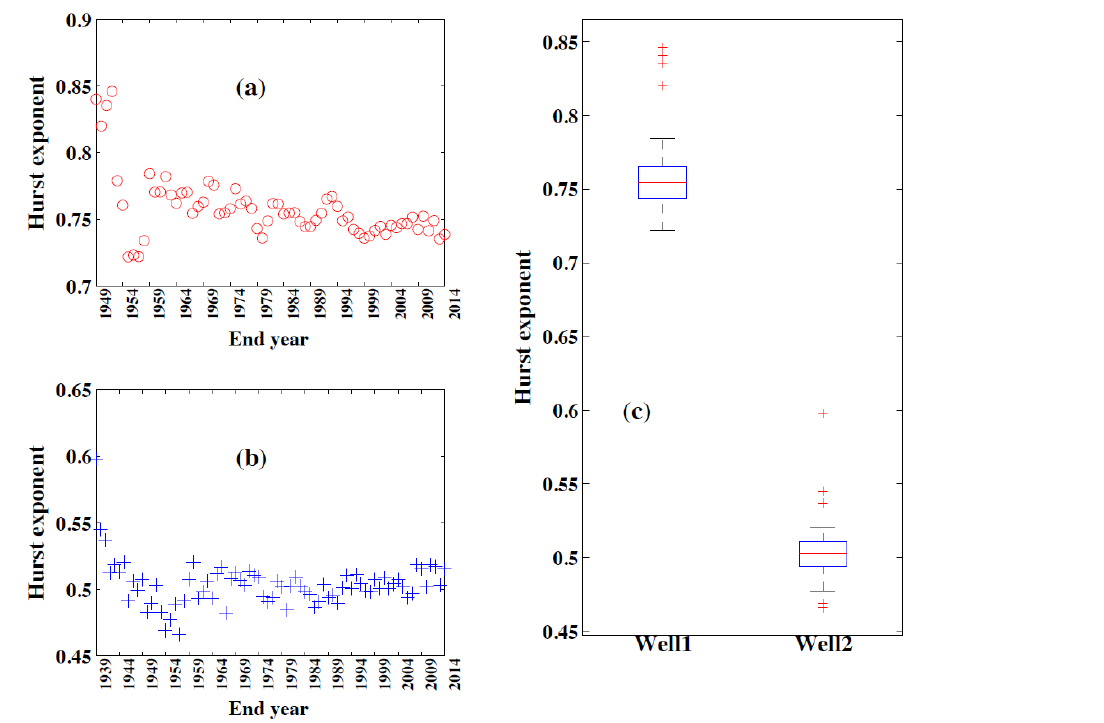
Figure 4. (a) The evolution of the Hurst exponent through time for Well 1 groundwater levels, which starts from 1945; (b) the evolution of the Hurst exponent through time for Well 2 groundwater levels, which starts from 1935; (c) box plots of the Hurst exponents in panels (a) and (b)